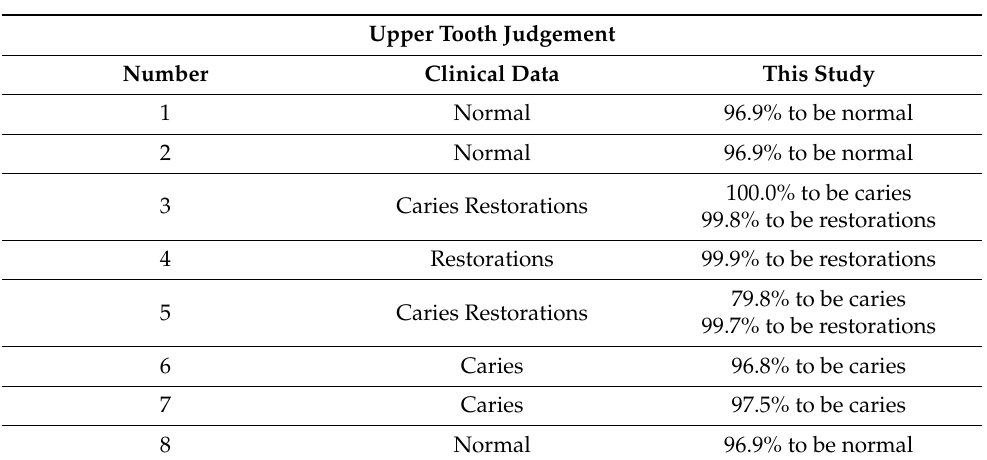
Table 6. Upper tooth judgement for teeth image in Figure 10.